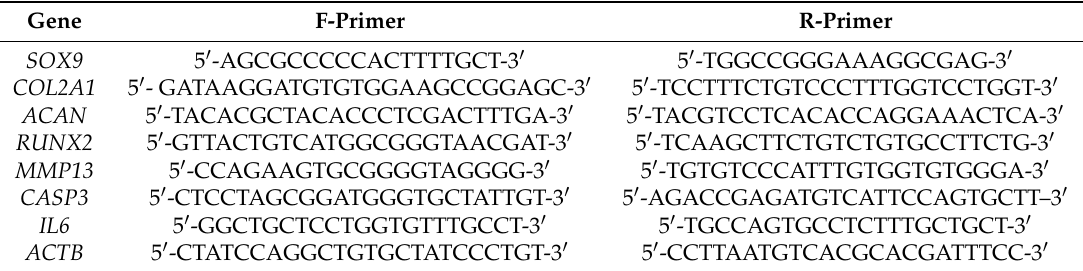
Table 1. Table of